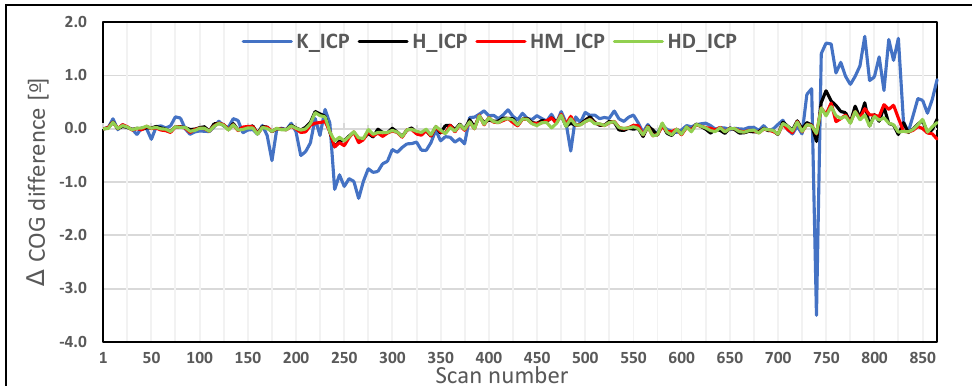
Figure 14. A graph of ΔCOG ICP − ΔCOG R increment differences.